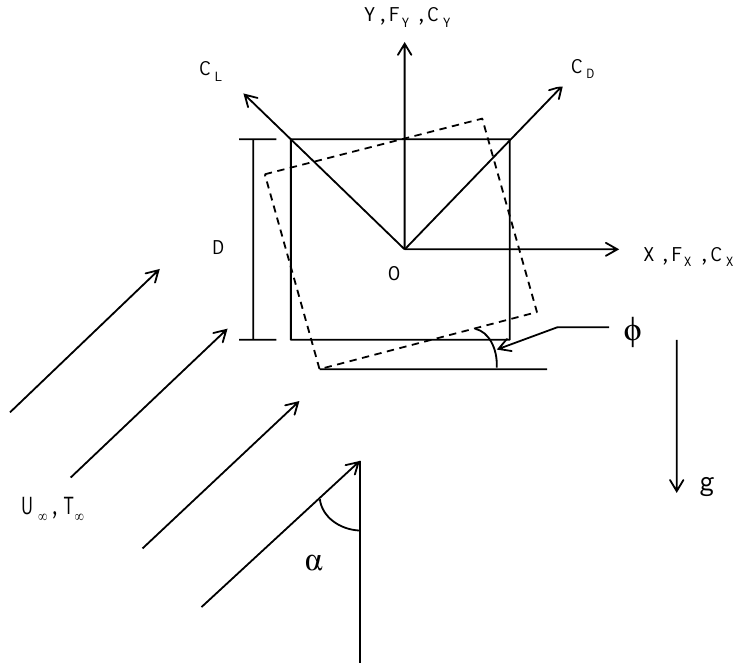
Figure 1. Geometry of the proposed problem in a two-dimensional framework.